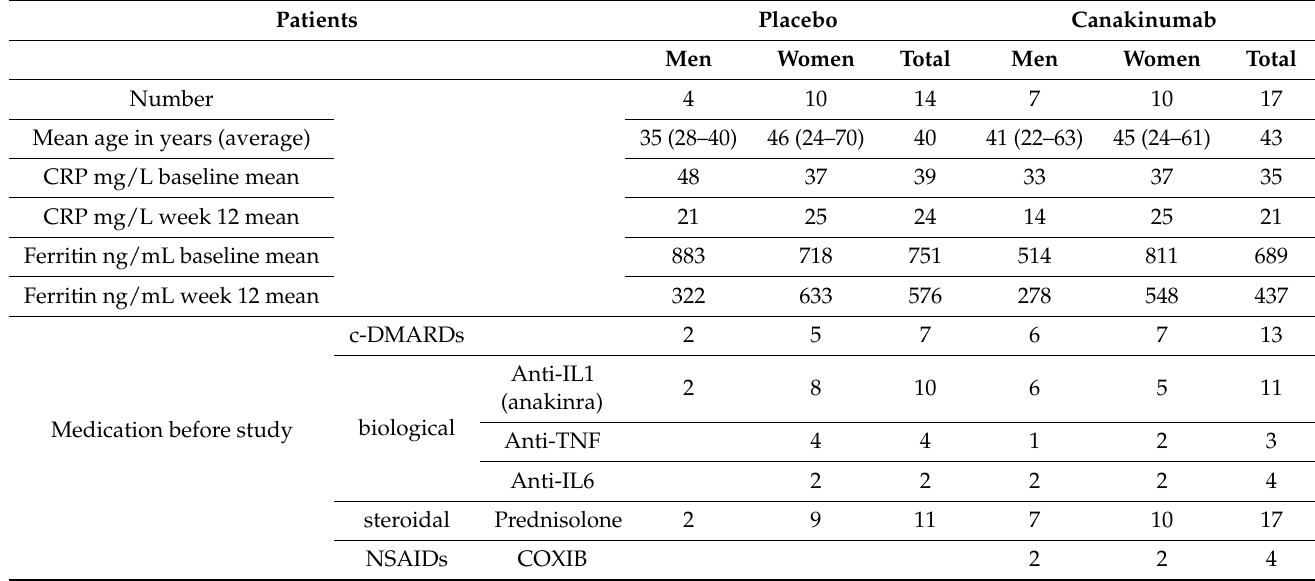
Table 1. Detailed characteristics of patients investigated in the